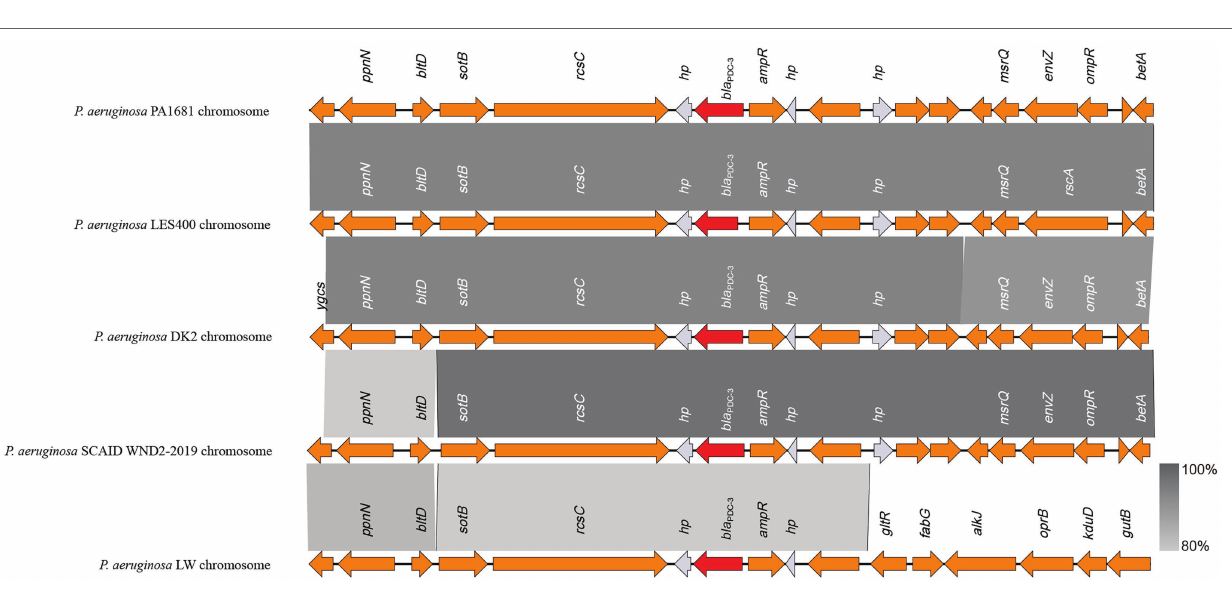
FIGURE 4 | Comparative genomic analysis of the bla PDC-3 -encoding fragment of PA1681 with other sequences from Pseudomonas aeruginosa strains: P. aeruginosa LES400 (CP006982.1), P. aeruginosa DK2 (CP003149.1), P. aeruginosa SCAID WND2-2019 (CP041786.1), and P. aeruginosa LW (CP022478.1). Annotated coding sequences are displayed as arrows. The grey shading areas indicate homologous regions (identity >80%). hp., hypothetical